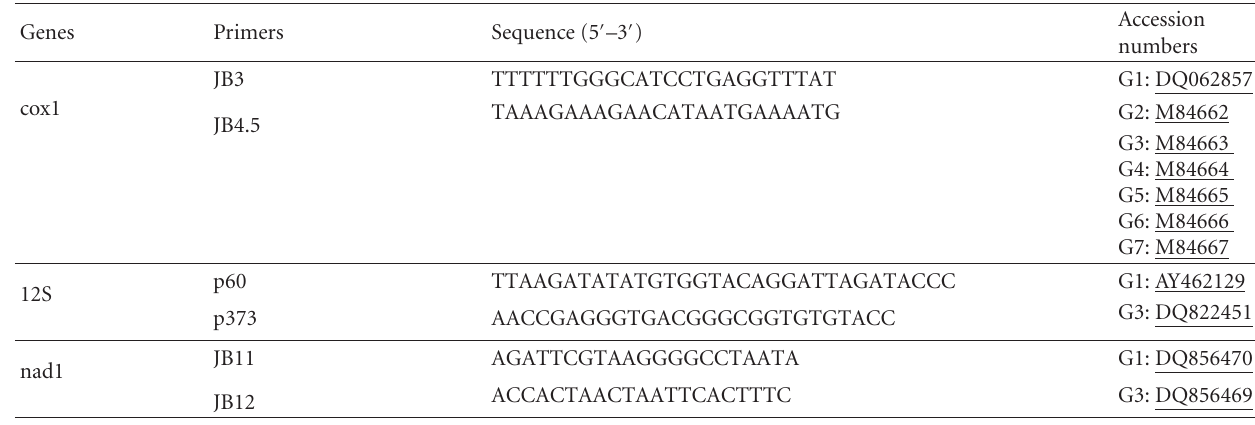
Table 1: Genes, primer sequences, and accession numbers used for genetic comparisons.